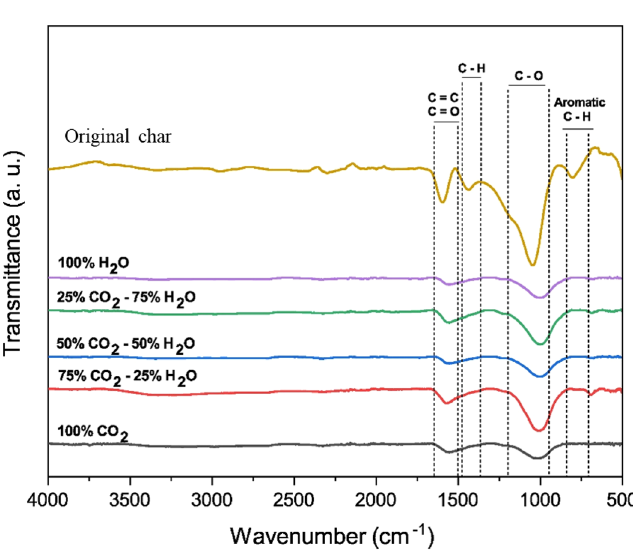
Figure 6. FT-IR spectra of activated char from D. linearis derived